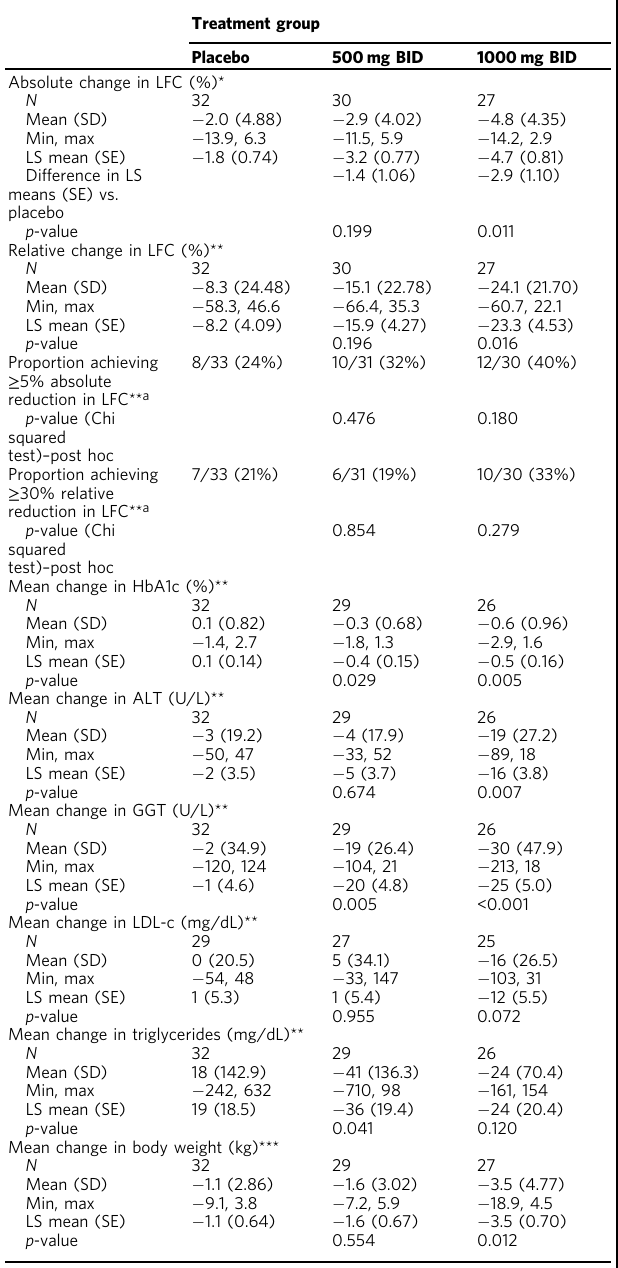
Table 2 Responses to therapy. Treatment